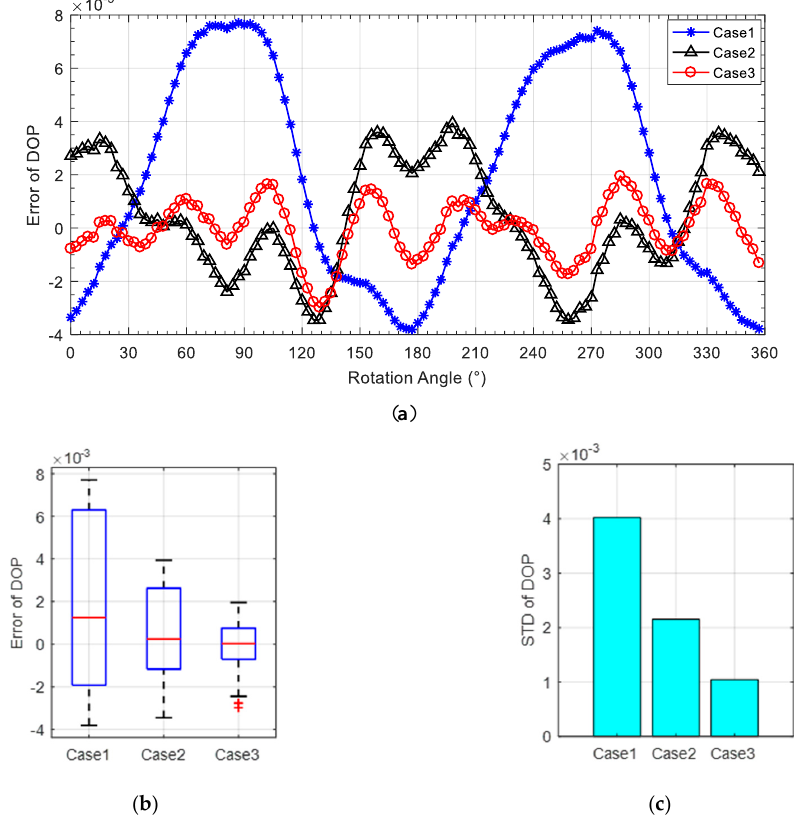
Figure 10. DOP-error comparison of three cases. ( a ) DOP-error curve comparison; ( b ) DOP error distribution; ( c ) SD of DOP-error comparison. Table 4. Statistics comparison of DOP error.